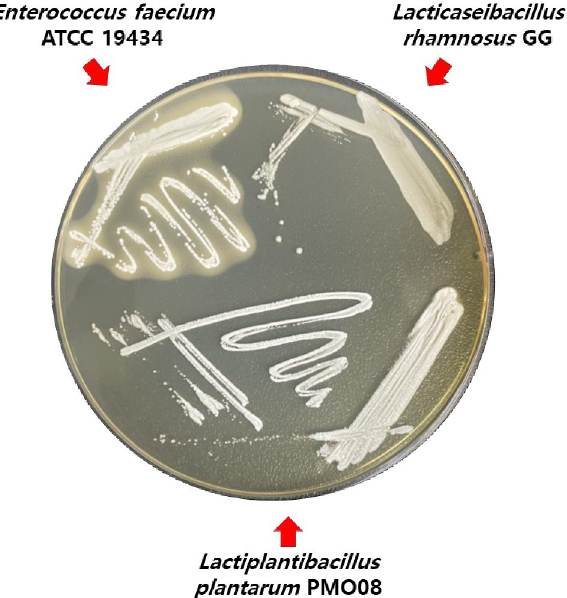
Fig 4. Bile salt deconjugation activity of Lactiplantibacillus plantarum PMO 08 on MRS medium containing 0.5% taurodeoxycholic acid. Plates were incubated anaerobically at 37˚C for 48 h. Enterococcus faecium ATCC 19434 used as a positive control and Lacticaseibacillus rhamnosus GG used as a negative control.